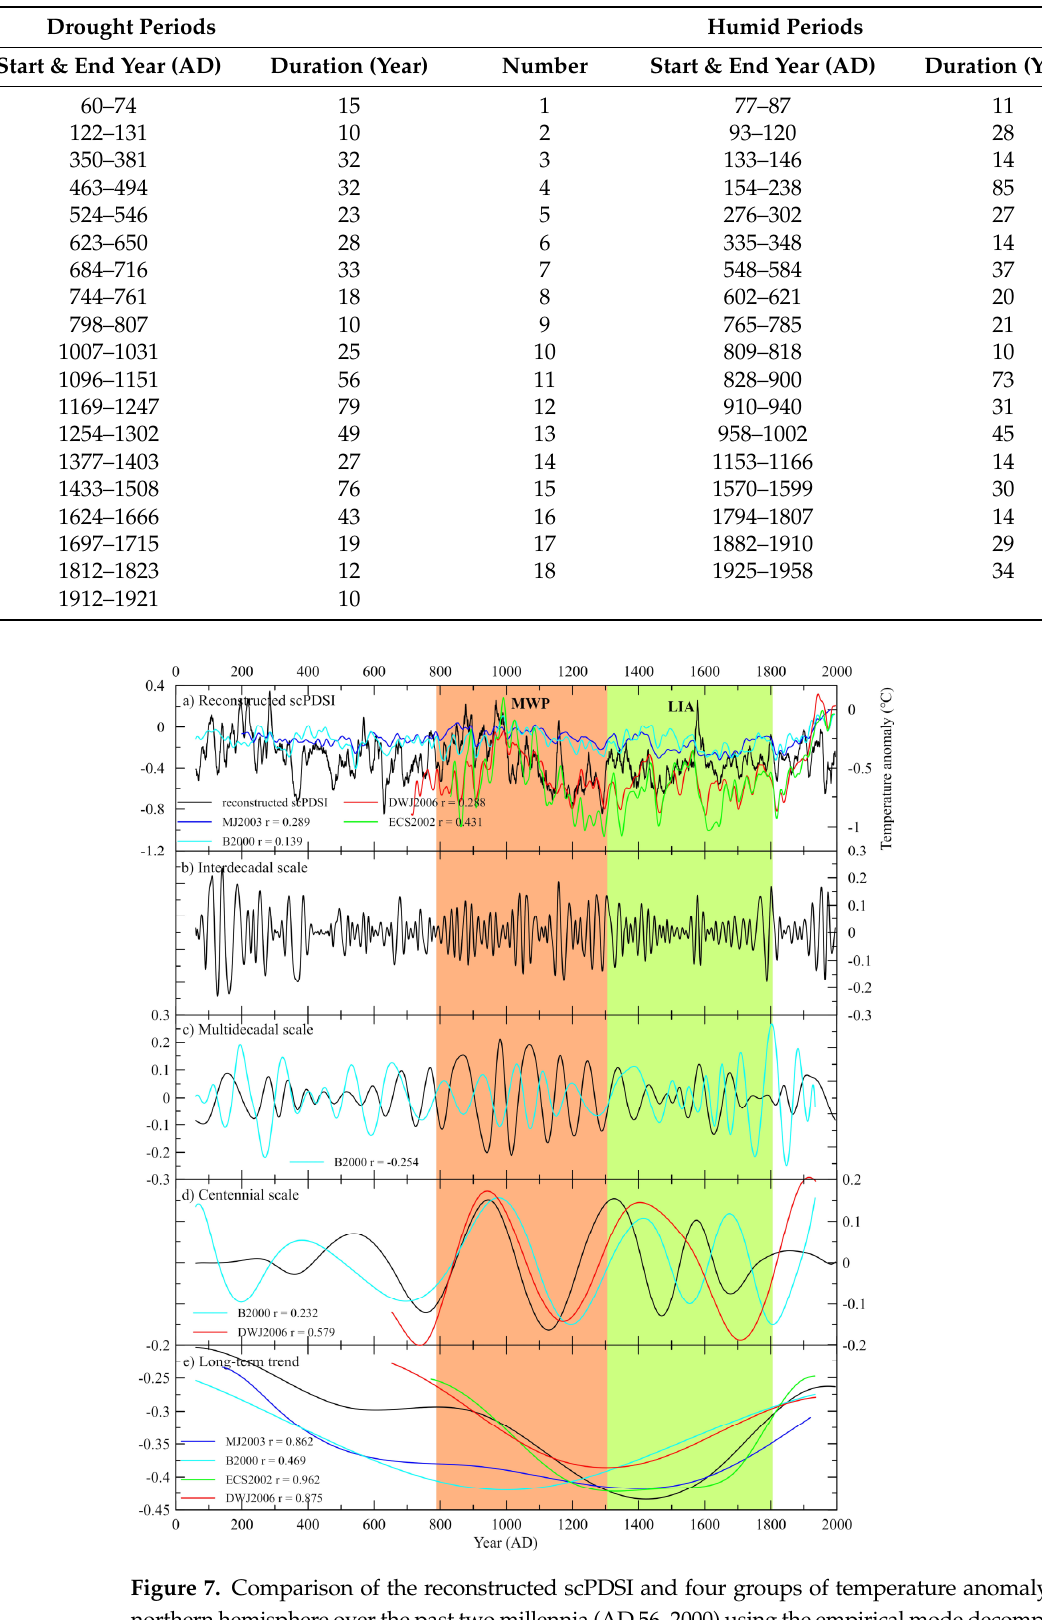
Table 3. Statistics of the significant drought/humid periods.